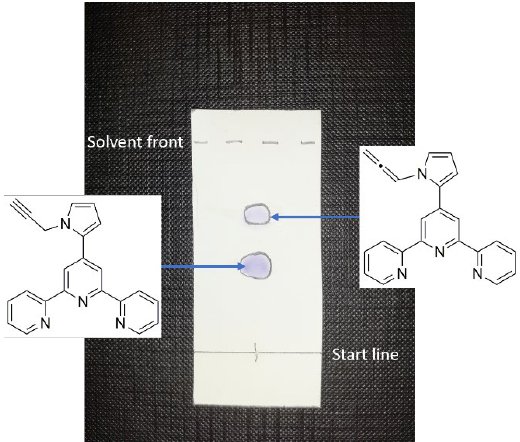
Figure 4. TLC onto alumina (cyclohexane/ethyl acetate 9:1 v / v ) of the crude mixture after staining with an aqueous solution of Mohr’s salt.